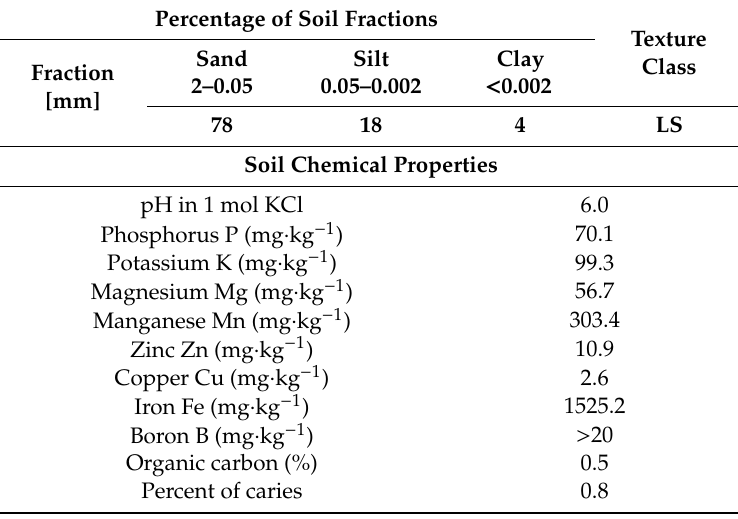
Table 2. The texture of soil sampled at a depth of 0–25 cm and the soil chemical properties of the 3-year